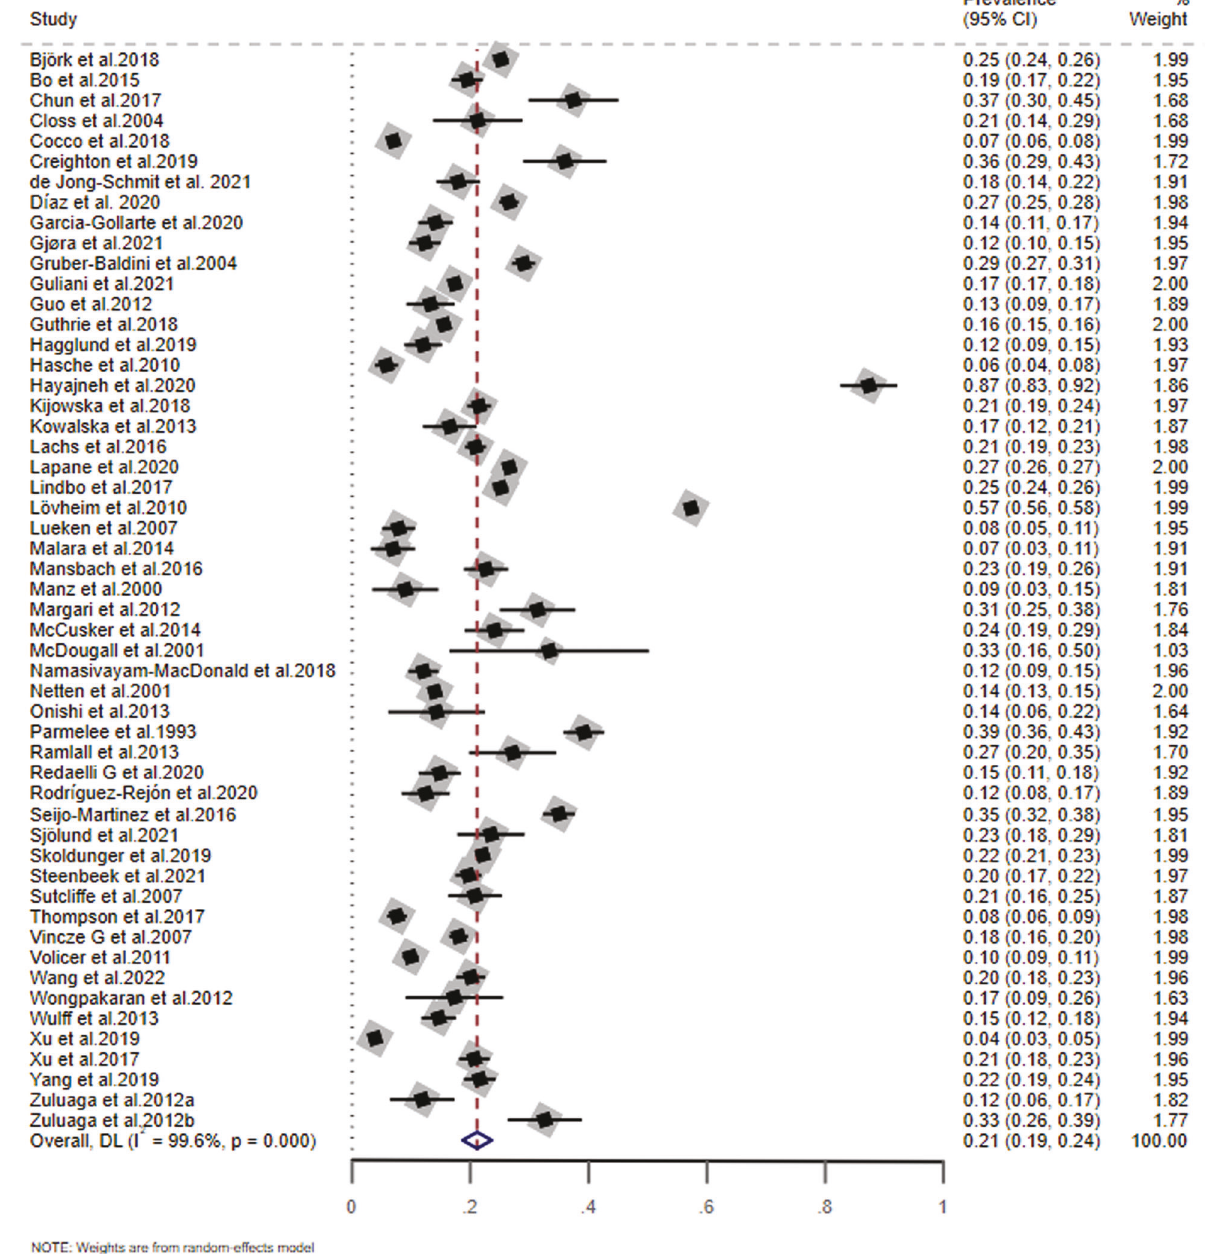
Fig. 2 The prevalence of MCI among older adults living in nursing homes. Pooled prevalence was estimated by random-effects model. MCI mild cognitive